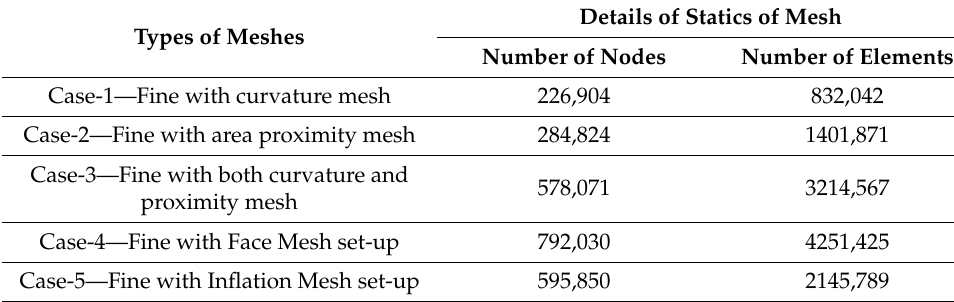
Figure 9. Grid Independence Test-I. Table 11. Comparative statistical information of all the mesh